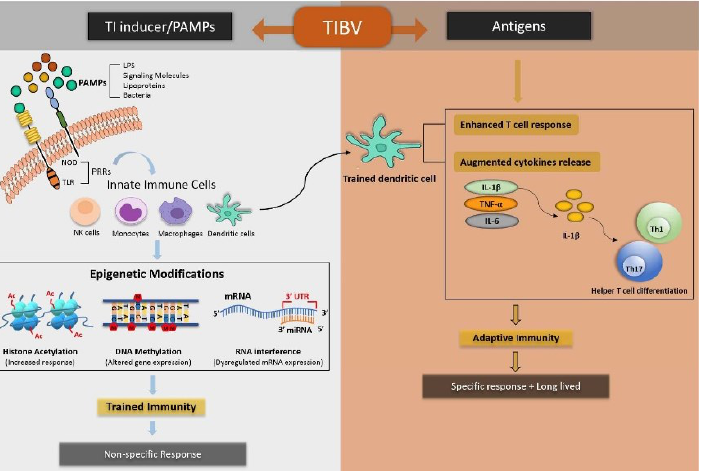
Figure 3. Mechanism of trained immunity-based vaccines. TibVs can induce both non-specific and specific immunological memory against heterologous pathogens. Non-specific immune memory is generated by trained immunity through epigenetic modifications in IICs in response to pathogen-associated molecular patterns (PAMPs). On the contrary, specific adaptive immune response/memory is produced against nominal antigens carried by TibVs through antigen presentation by APCs (antigen-presenting cells) as well as by the release of pro-inflammatory cytokines such as IL-1 β , IL-6, and TNF- α , secreted by the trained IICs. Different mechanisms are involved in the induction of trained immune responses during infections. BCG vaccination in healthy humans induces the transcriptional changes